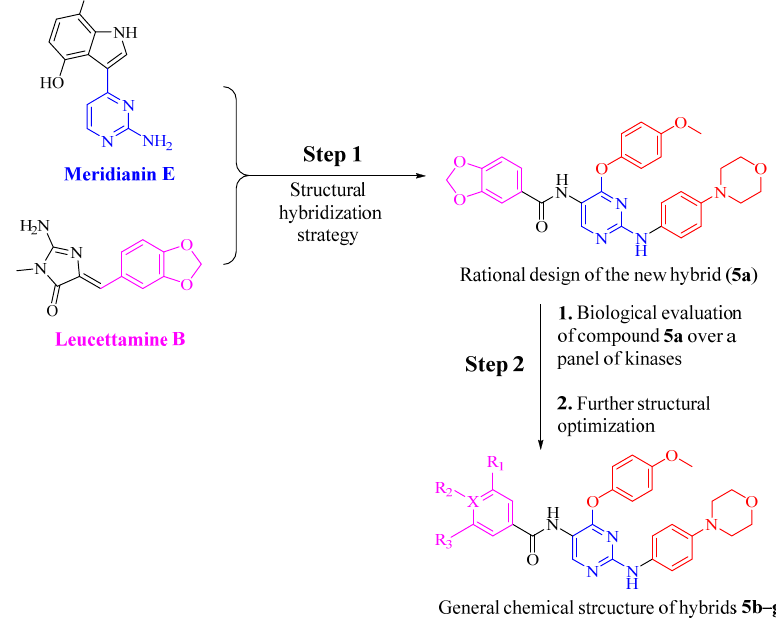
Figure 1. Rational design steps of the new set of Meridianin E and Leucettamine B hybrids ( 5a – g